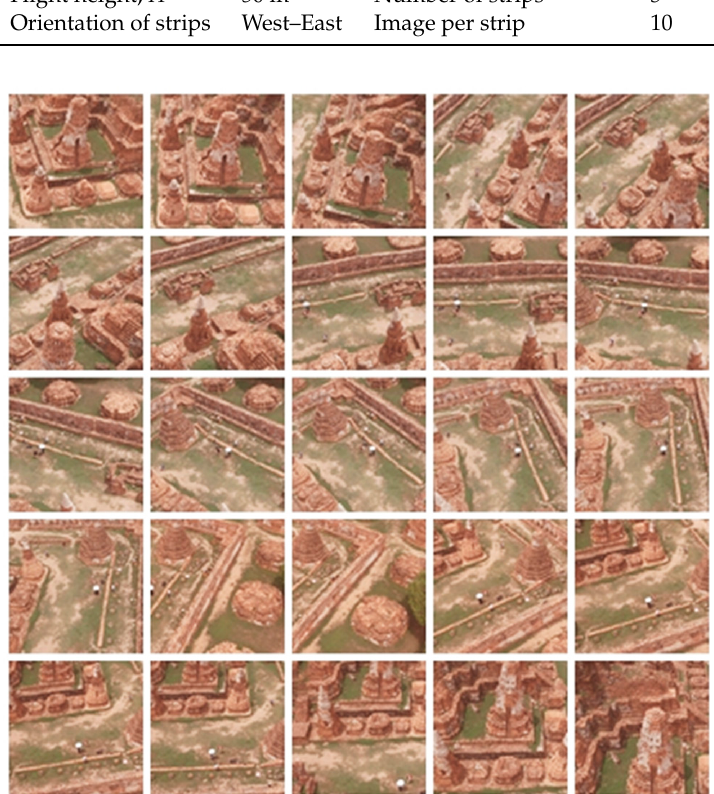
Figure 5. Overlap and sidelap images established from flight planning and control.